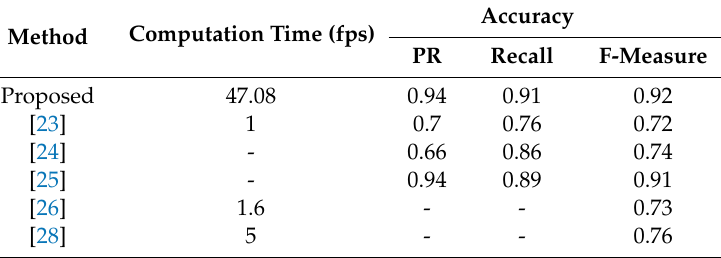
Table 3. Comparison of performance